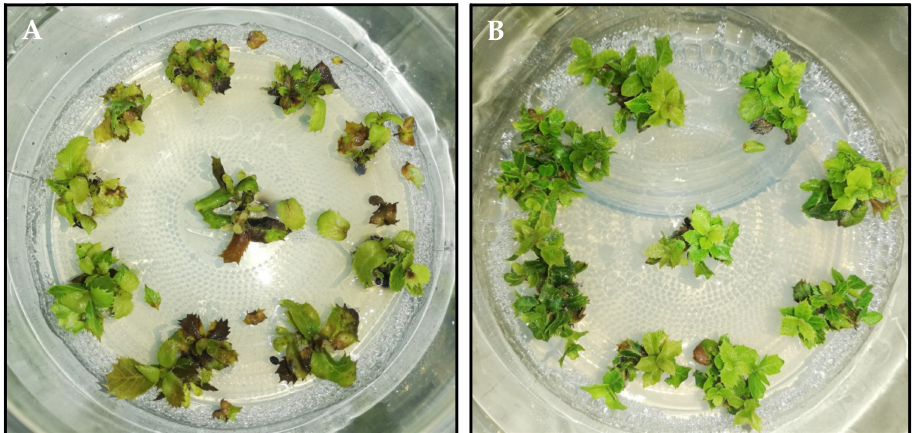
Figure 2. Medium-term conservation of axillary shoot cultures of holm oak by cold storage. ( A ) Ap- pearance of shoot cultures of clone VA11-Bs after storage for 12 months at 4 ◦ C under dim light conditions. ( B ) Axillary shoot proliferation of VA11-Bs clone after 12 months of cold storage and 4 weeks on proliferation medium under standard conditions. Jar diameter: 90 mm.